Question: What form of chart is displayed?
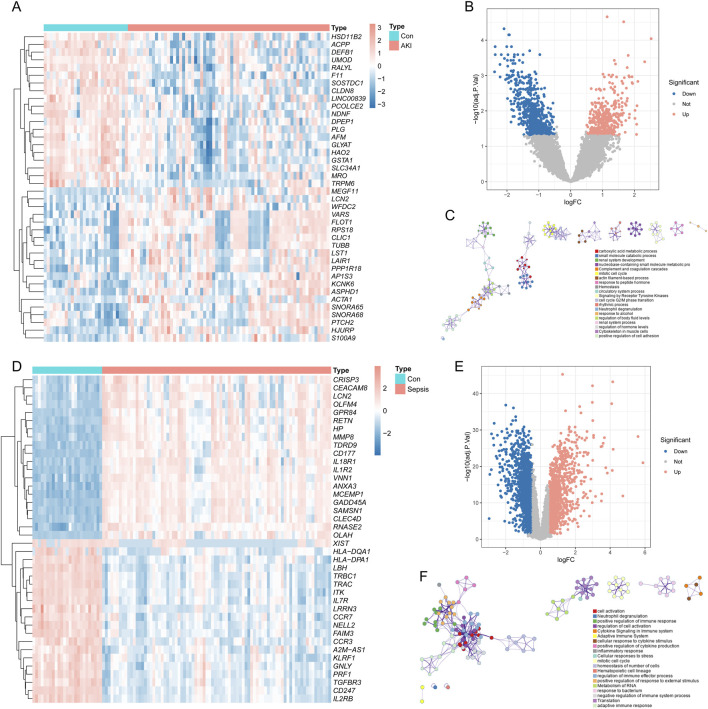
Answer: heatmap